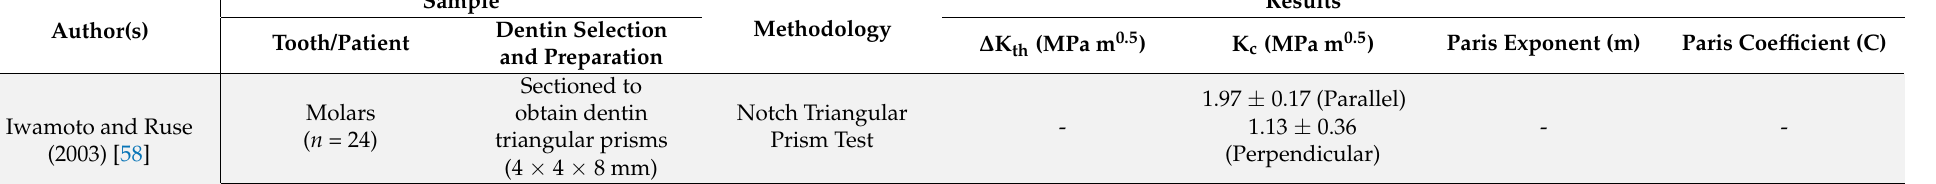
Table 3. Results of Dentin Fatigue